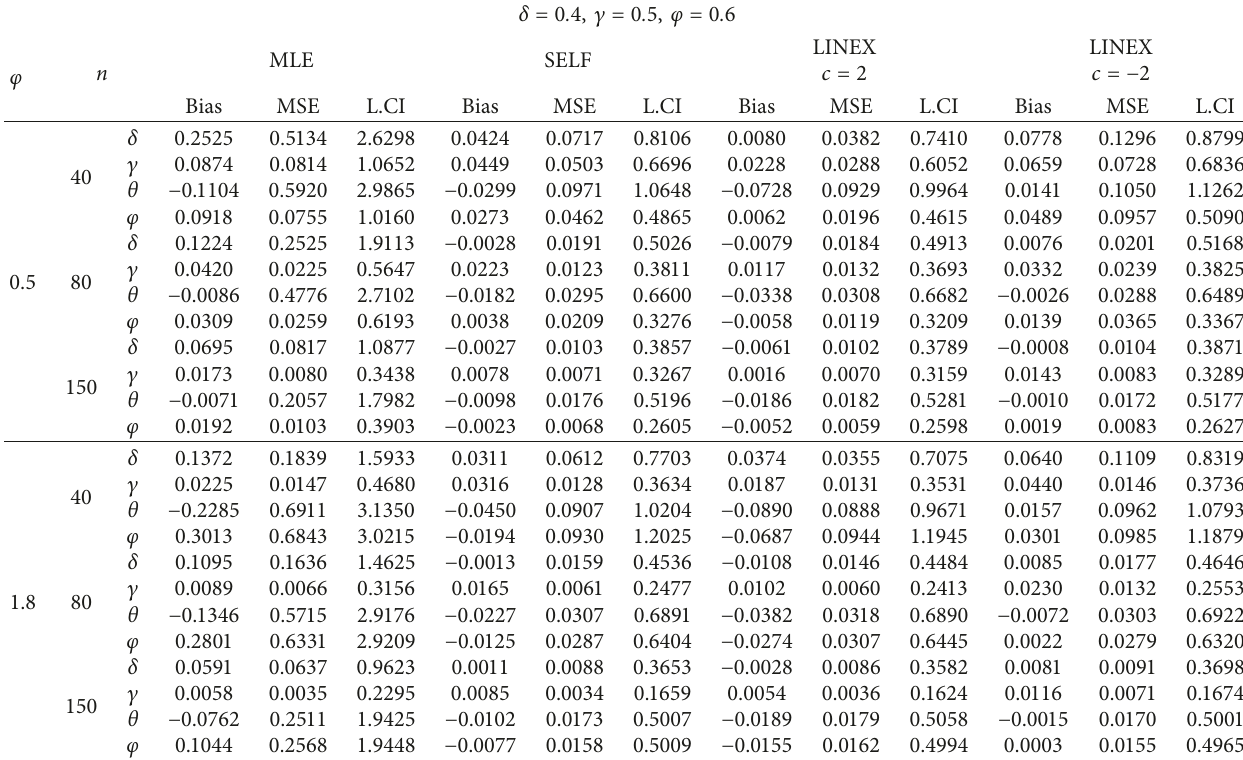
Table 4: Bias, MSE, and L. CI for MLE and BE for case I.